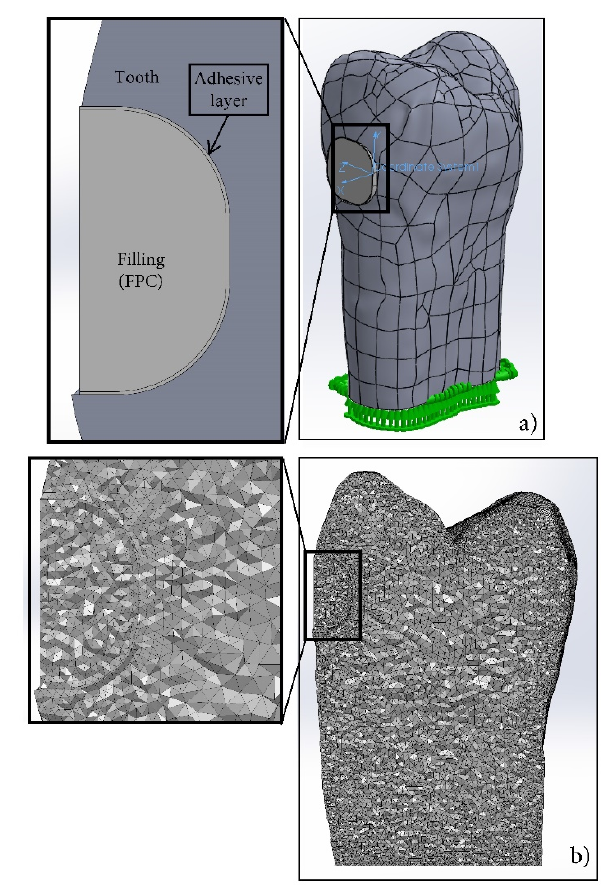
Figure 2. Virtual model of tooth 15: ( a ) fixed tooth with filling of flowable composite; ( b ) mesh used in simulation. Table 1. Data for materials used in the simulations [22–28].